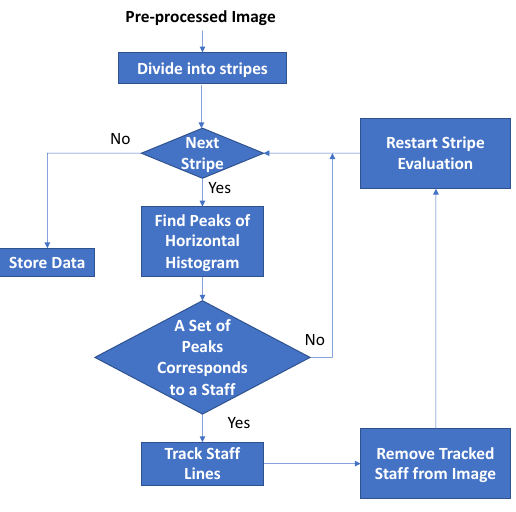
Figure 5. Diagram of the staff search